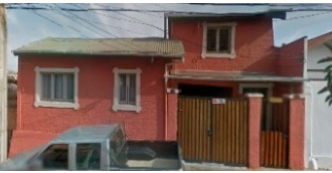
Figure A4. Façade of inspected building (ID = 599 in [81]). Image data © Google Street View 2019. Table A2. Data collection for the building in Figure A4.